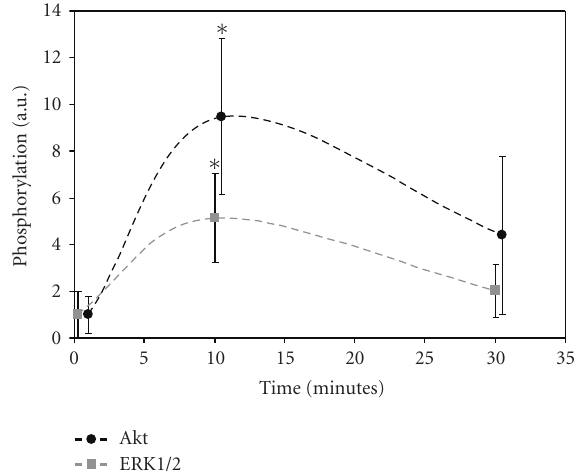
Figure 1: Activation of mechanotransduction pathways by shear. HUVECs were subjected to shear stress for di ff erent periods. Subsequently, the amount of phosphorylated Akt and ERK1/2 was determined by immunoblotting. After 10 minutes, phosphorylation levels were significantly higher ( ∗ P < . 01, Student’s t -test) compared to levels in statically cultured cells. After 30 minutes, this significant increase was no longer